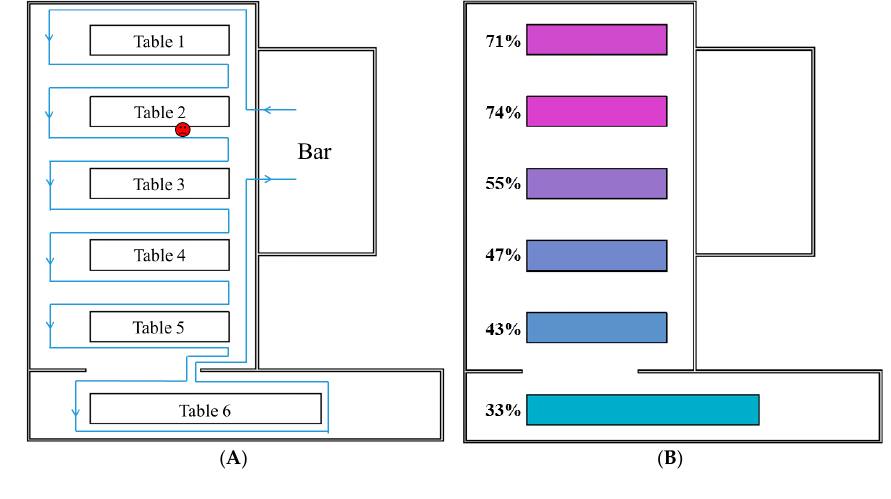
Figure 1. Floor plan of the site of the outbreak (restaurant) and the attack rates at different tables [21]. The location of the index patient is marked in